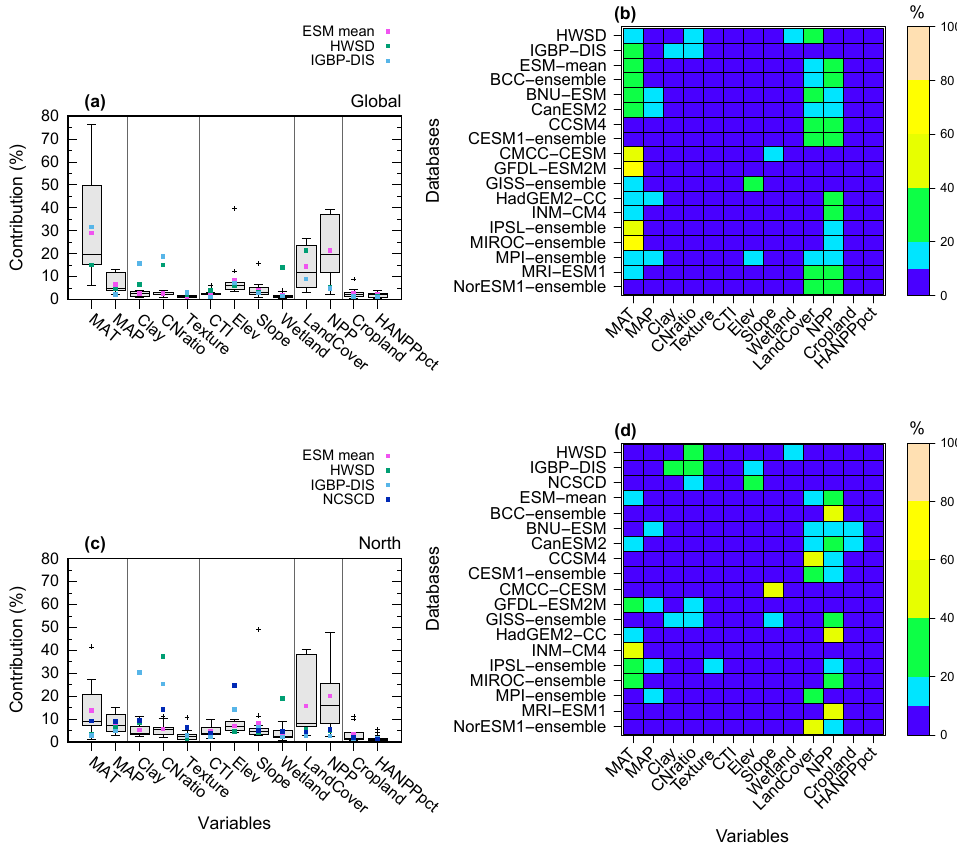
Figure 5. Relative contribution (influence) of predictive variables for the model of the soil carbon stock from ESMs and a comparison with those of observational databases. Box plots show the results of ESMs, and the purple, green, light blue, and blue marks indicate the mean of the ESMs and results from observational databases ( a : global; c : north). Mosaic plots of detailed relative contributions for each ESM ( b : global; d : north) are